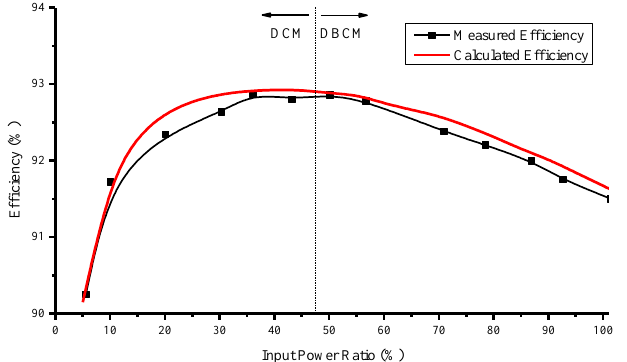
Figure 9. Calculated and measured efficiency versus power ratio for 60 °C ( P PV,max = 140 W, V dc = 31 V).